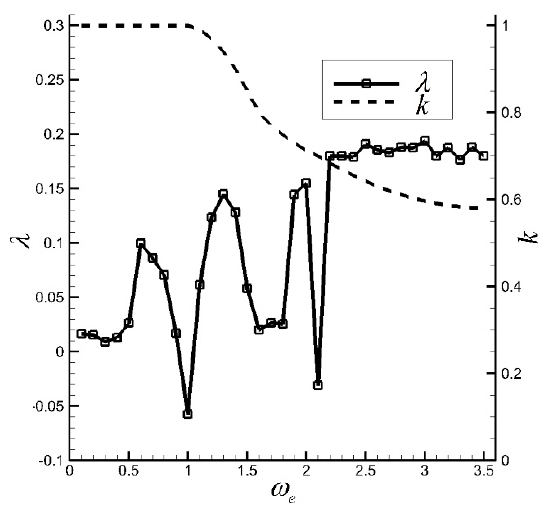
Figure 5. MLE ( λ ) of the simplified model with traveling wave wall control.